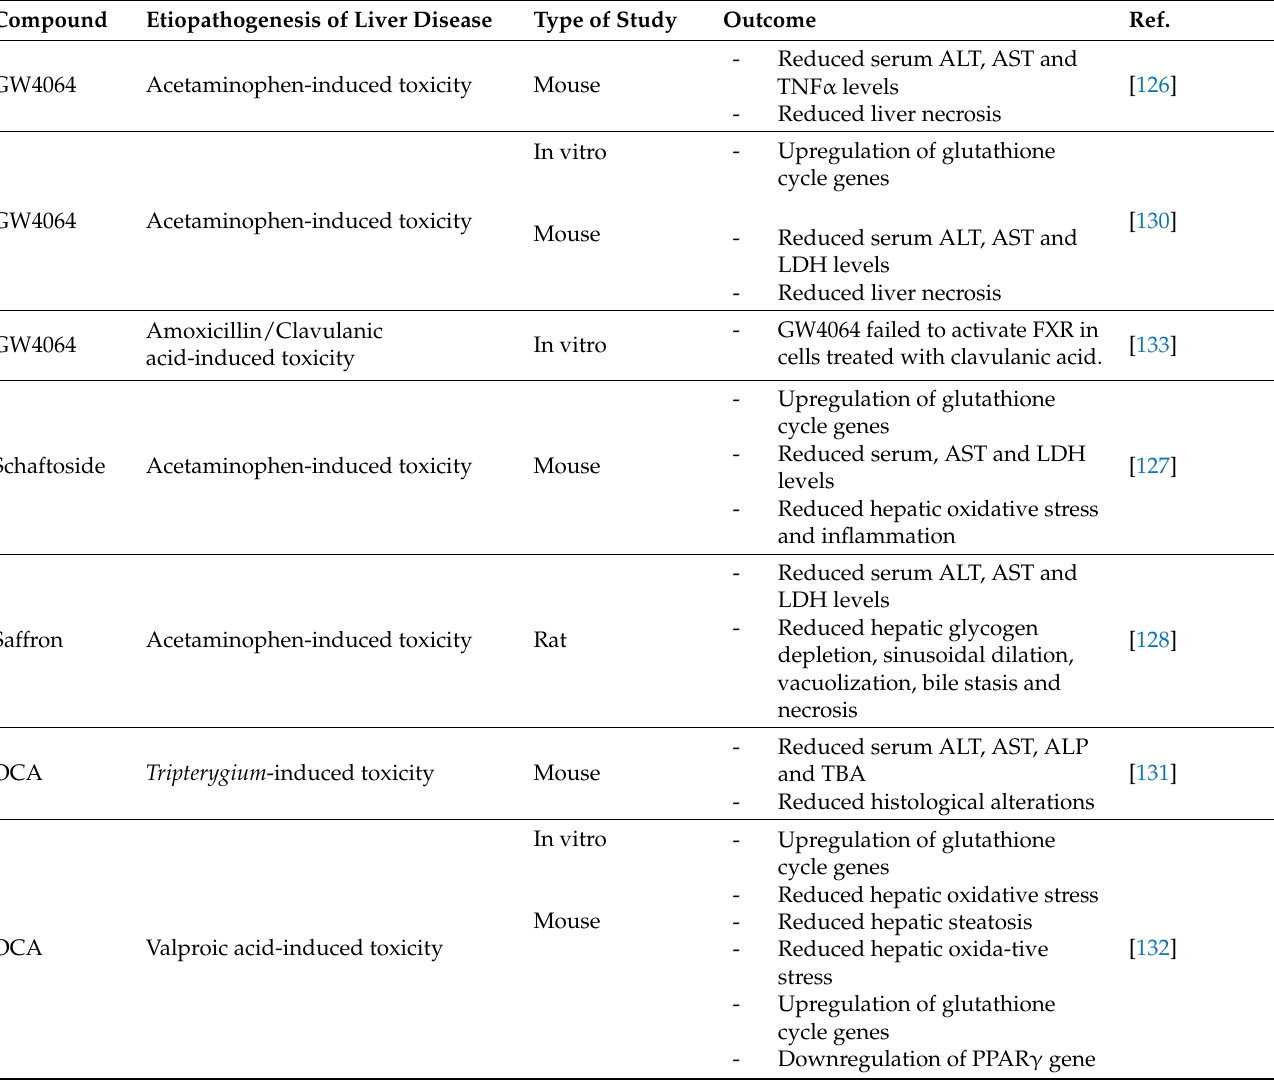
Table 1. Effects of pharmacologic activation of FXR on drug-induced liver